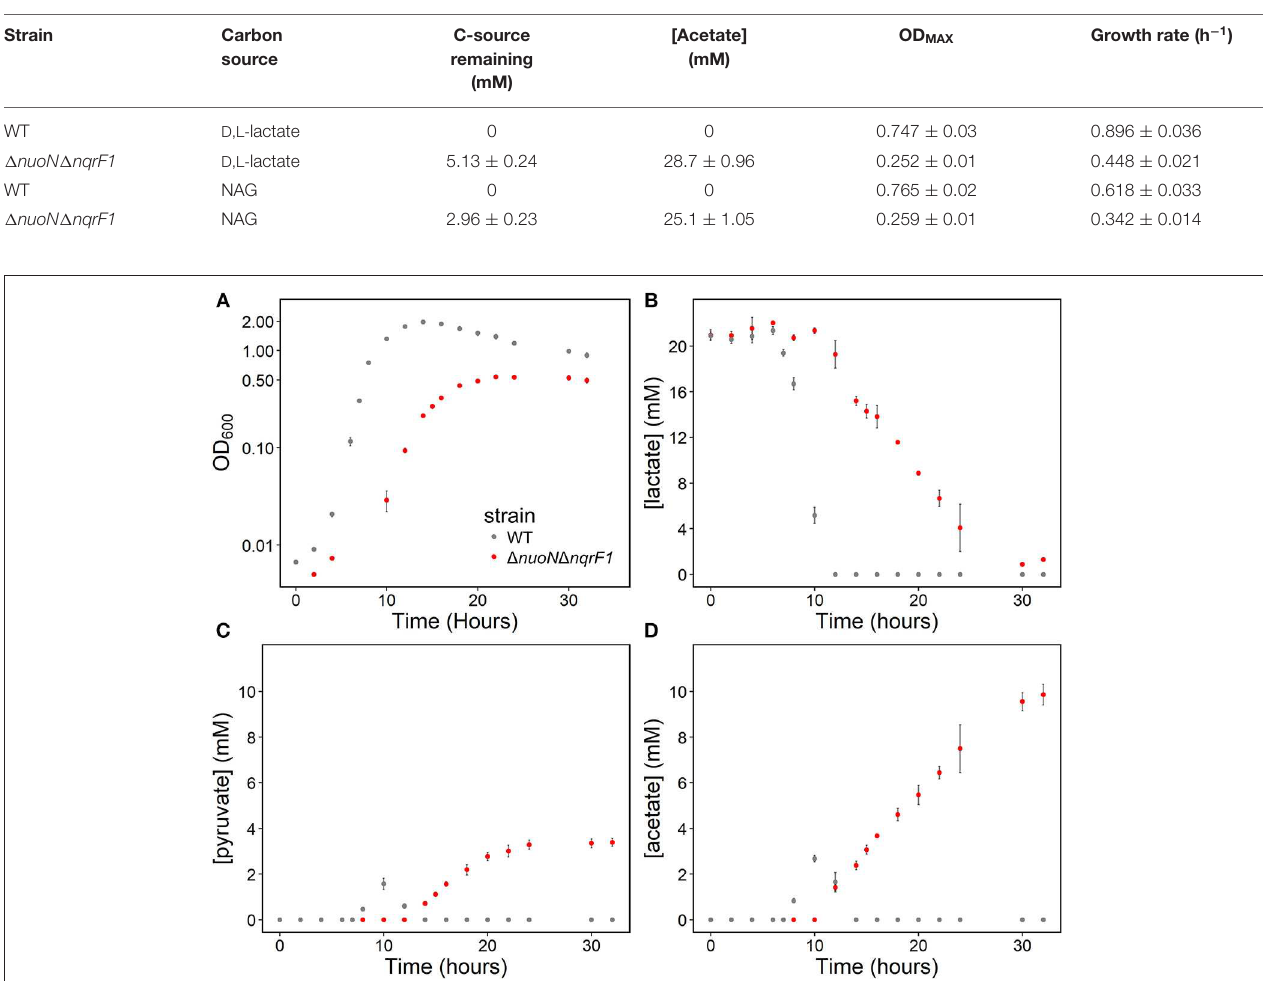
TABLE 1 | Growth and endpoint HLPC analysis of carbon source utilization from 24-well plate experiments after 48-h runtime in M5 supplemented with 0.1% tryptone and 20mM D,L -lactate or 10mM NAG from Figure 2 .